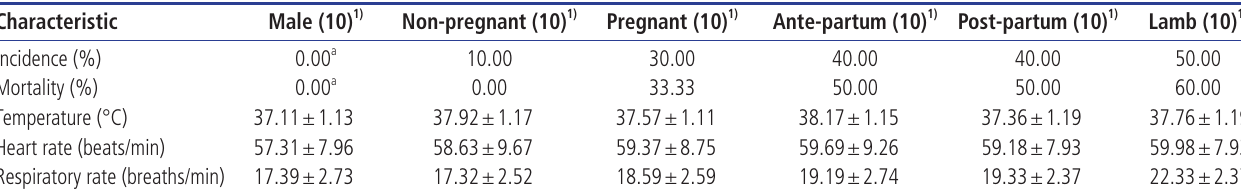
Table 1. Results of clinical examination of affected Qianbei-Pockmarked goats Characteristic